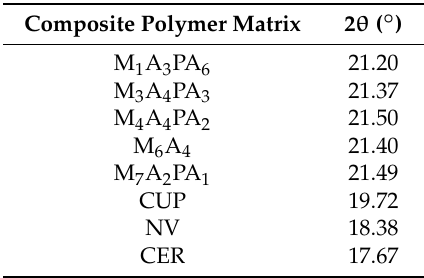
Figure 3. X-Ray Diffraction spectra from the pure BaTiO 3 nano-particles and specimens with 0%, 5%, and 20% w/w in BaTiO 3 , in the M 1 A 3 PA 6 unsaturated polyester polymer matrix. Table 5. 2 θ values from each amorphous polymer peak of all developed nano-composites.